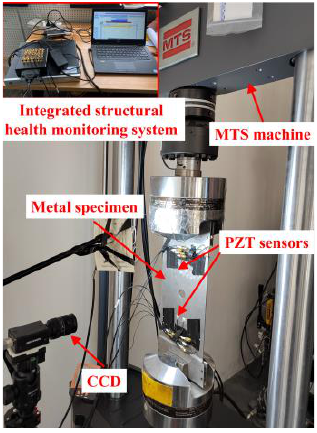
Figure 7. Experimental setup for center-hole metal specimens.